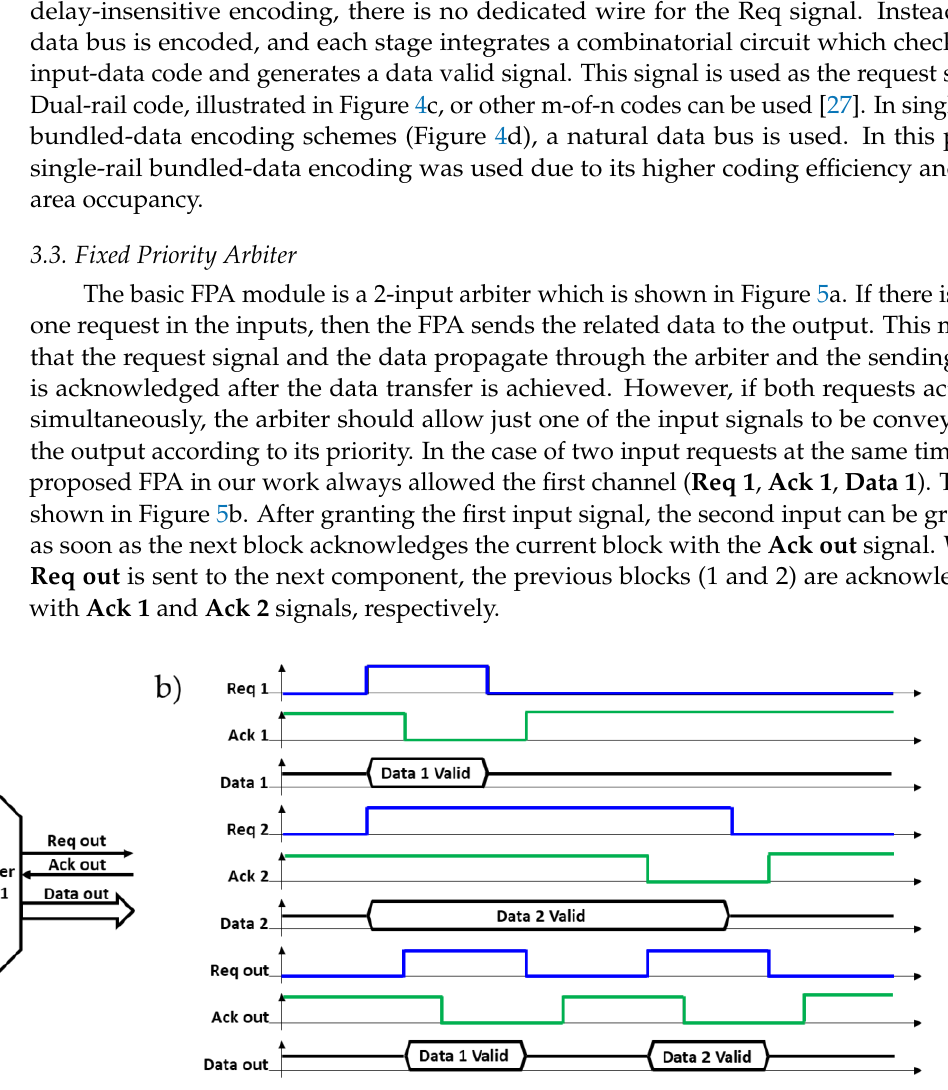
Figure 5. ( a ) Fixed-priority two-to-one arbiter managing to extract the data generated by two different units connected at its input. ( b ) Functioning principle illustration of the two-to-one arbiter when the two input data are presented at the same time. The first data are extracted followed by the second.